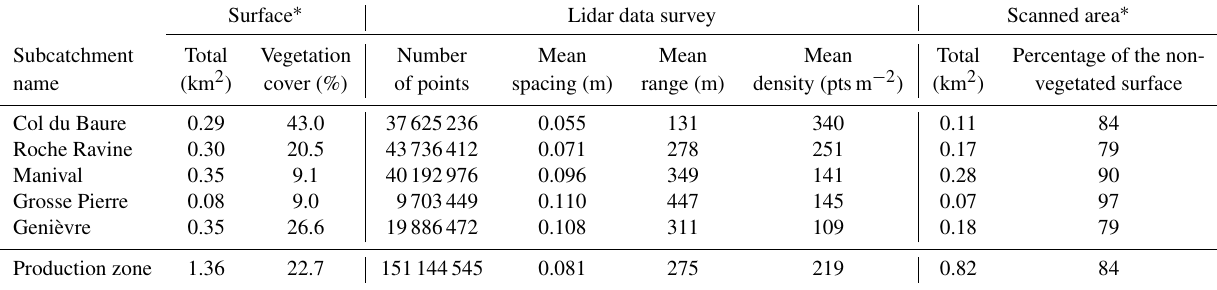
Table 2. TLS data and surface coverage characteristics of the five subcatchments from the first monitoring period (MP1). As the view points and parameters of acquiring remained similar, the values are essentially the same for all